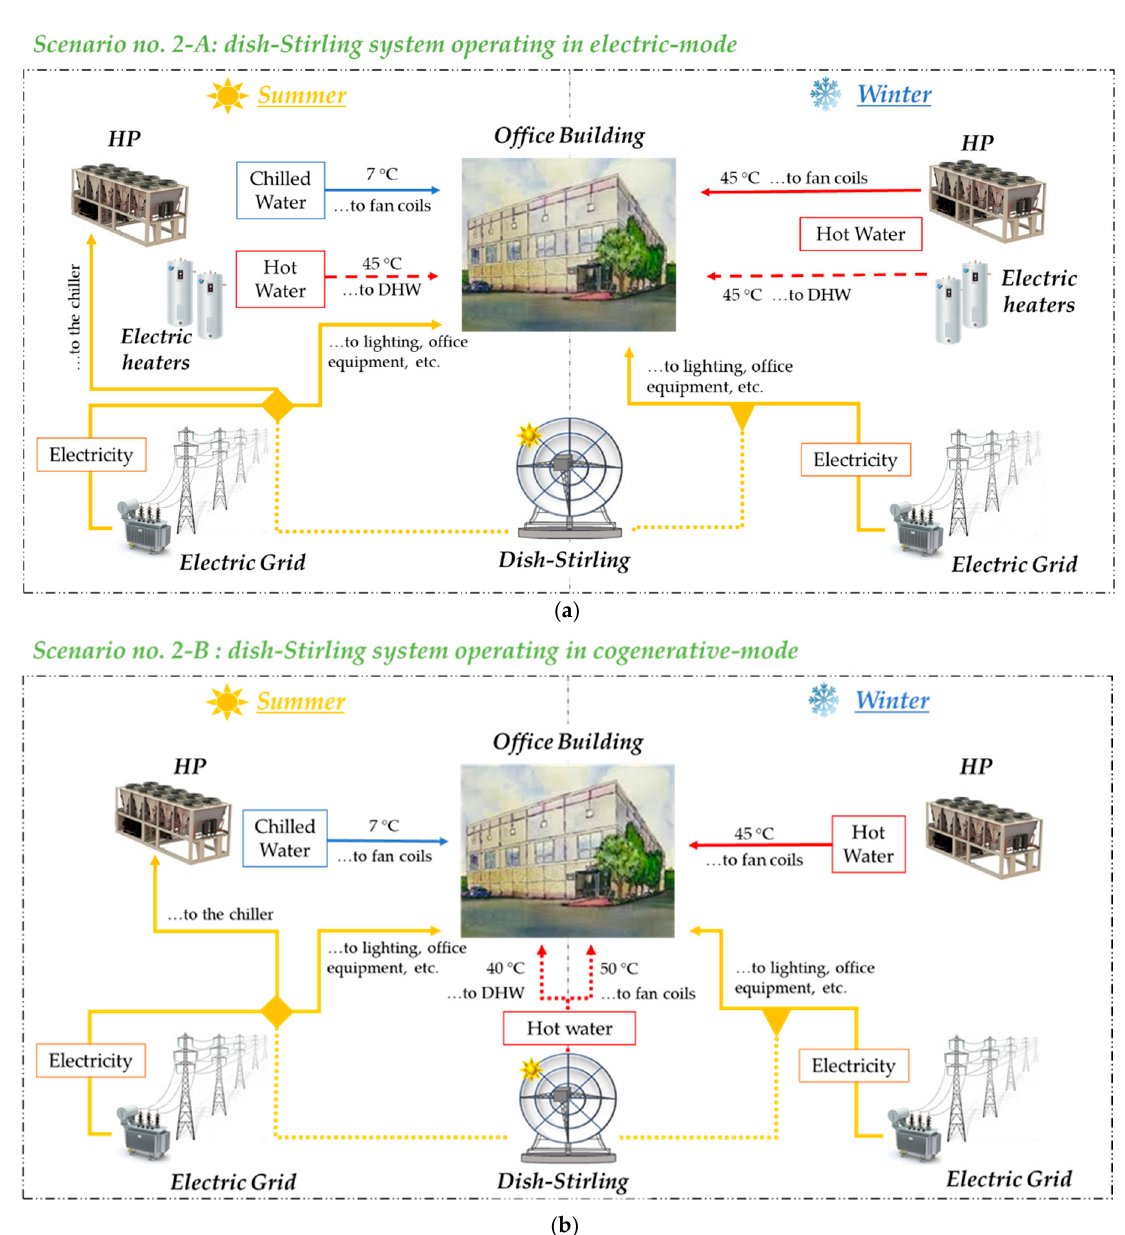
Figure 8. Improved scenarios for System no. 2: ( a ) dish-Stirling system operating in electric-mode and ( b ) dish-Stirling system operating in cogenerative-mode.